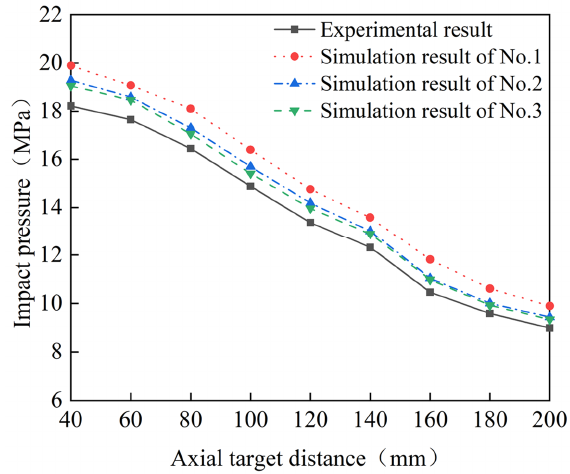
Figure 10. Comparison between the numerical simulation and experimental results of the axial distribution of the jet impact force of circular nozzle. Table 4. Error analysis of the numerical simulation and experimental results.